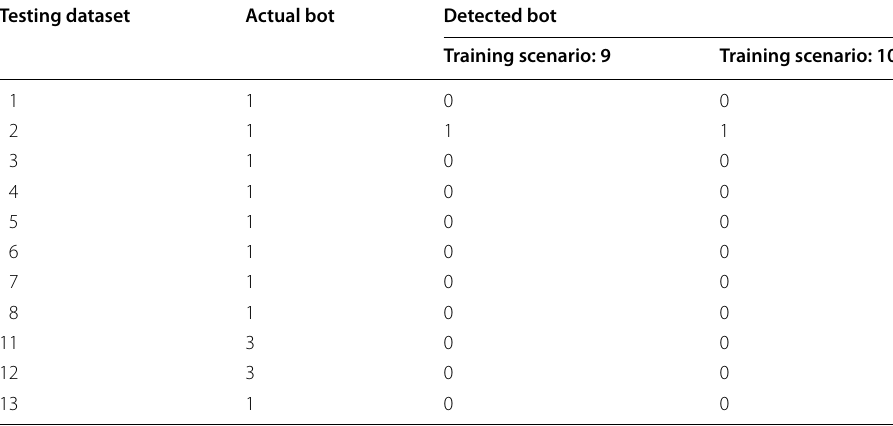
Table 6 Number of detected bots using SVM Testing dataset